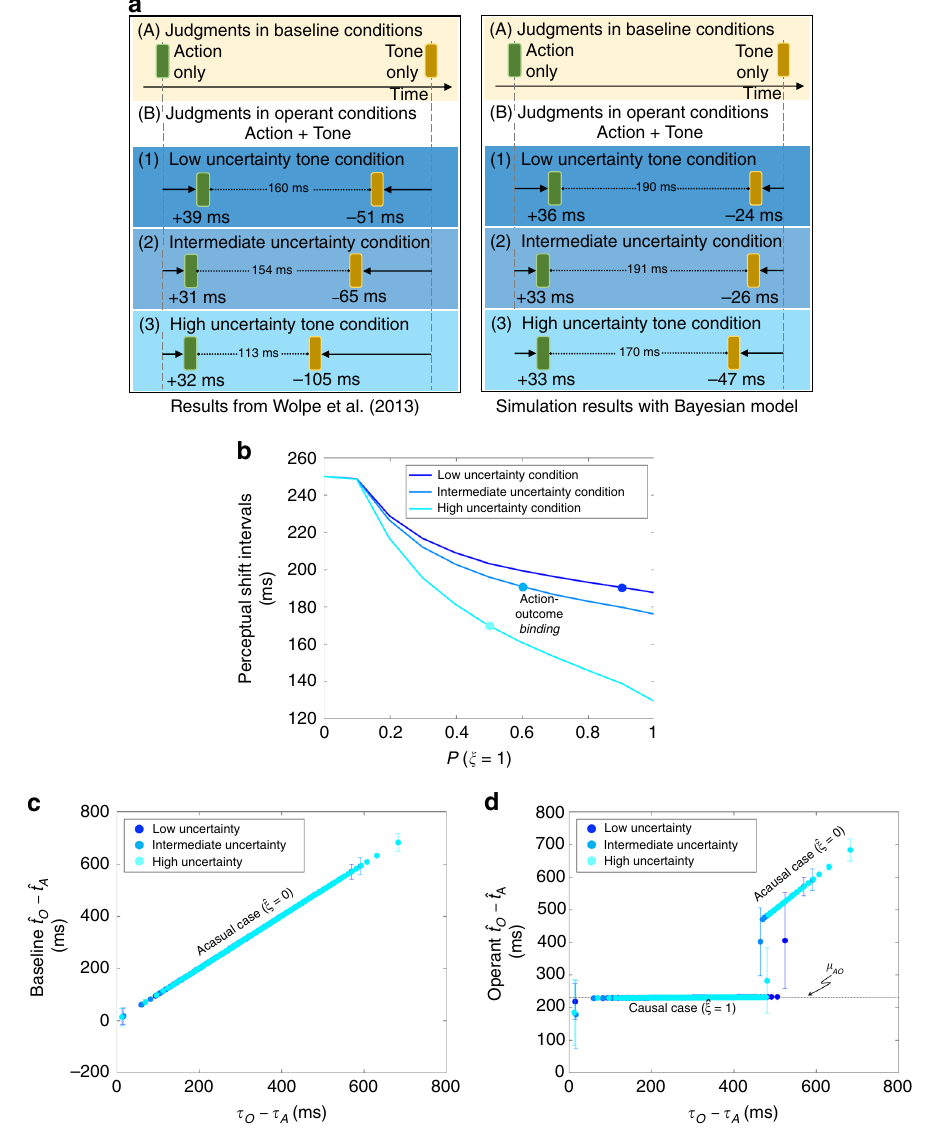
Fig. 5 Qualitative replication of, as well as predictions related to, the results reported by Wolpe et al. 22 . a Qualitative replication of the experimental results (left panel) by our Bayesian model (right panel). b The action-outcome binding increases under heightened uncertainty. However, causality is less detected when the causal prior is lower, which decreases the action-outcome binding effect. The best estimates of the Bayesian model in a were obtained from different causal prior strengths, speci fi cally P ( ξ = 1) is 0.9, 0.6, and 0.5 (marked by the colored dots) for the low, intermediate, and high tone uncertainty conditions, respectively. c , d The causal prior strengths that correspond to each condition were used for the Bayesian estimate of the action-outcome (cid:3) ^ t timing interval ^ t in the baseline and operant conditions. The Bayesian estimate follows the sensory inputs in the baseline condition where all trials are O A acausal, but shifts towards the prior assumption, τ O − τ A ≈ μ AO , when causality is detected. The temporal window of τ O − τ A for detecting causality is wider when the outcome uncertainty is lower, which means more instances demonstrate